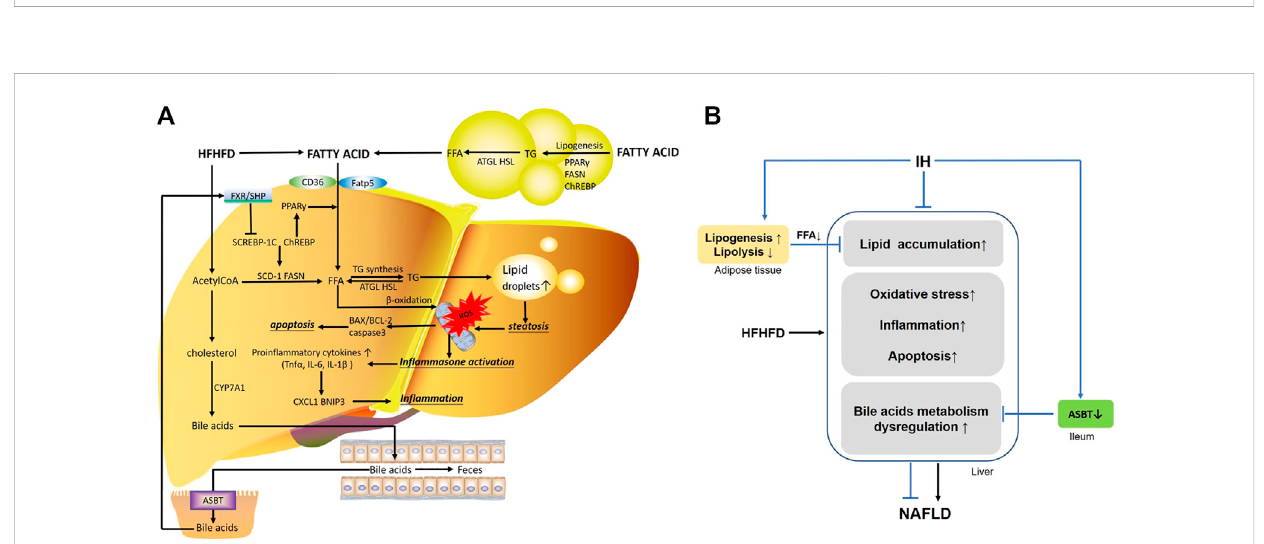
FIGURE 9 The main mechanisms involved in the interaction of IH and HFHFD. (A) FFA in the liver are from different sources, including FFA uptake from diet or lipolysis in adipose tissue via CD16 or Fatp5, and de novo lipogenesis stimulated by Srebp-1c, Chrebp and PPAR- γ . HFHFD-induced FFA and acetylCoA fl ux are shunted to lipid synthesis (TG) rather than β -oxidation, leading to steatosis. Overwhelmed lipids impair mitochondrial function, promote ROS production and cause oxidative stress. Meanwhile, in fl ammasomes are activated and increasing pro-in fl ammatory cytokines or chemokines (e.g., TNF α ,IL-6, IL-1 β ,BNIP3 andCXCL1) arereleased. These stressful conditionsin fl uencethepro-apoptoticandanti-apoptotic factor(e.g.,BAX,BCL-2) and trigger apoptosis, resulting in exacerbated liver injury. Additionally, part of acetylCoA is converted into cholesterol, which is the substrate for bile acids synthesis by CYP7A1. Hepatic bile acids are excreted into the gut lumen, most of which are reabsorbed by ileal ASBT and transported back to the liver via the portal circulation. Bile acid activates FXR/SHP axis and functions as a regulator in cellular physiological procedures such as lipid metabolism, playing animportantroleinliverfunction. (B) IHexposureprotectsliverfromlipidaccumulation,oxidativestress,in fl ammationandapoptosisinHFHFDmice.The preventiveeffects of IH liver injury are also achieved by limited uptake ofFFAs mobilized from adipocytetissue, and interruption of theenterohepatic bile acids circulation by ASBT